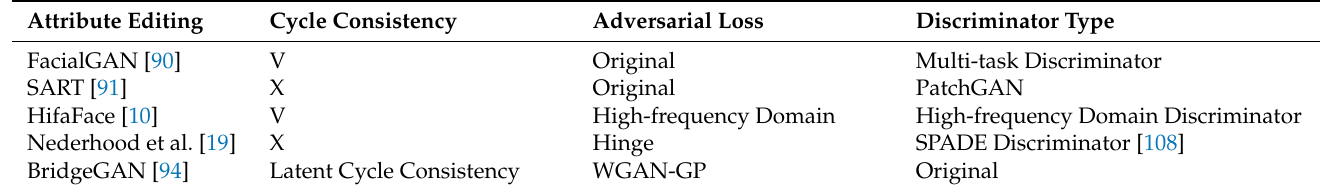
Table 7. Comparison between papers in the Attribute Editing category (Section 8). For this category, the comparison is based on whether a given method uses the cycle consistency, adversarial loss and the discriminator architecture. “V” and “X” means that the method use the technique in the columns is “used” and “not used” respectively. “-” indicates that the corresponding information has not been found.